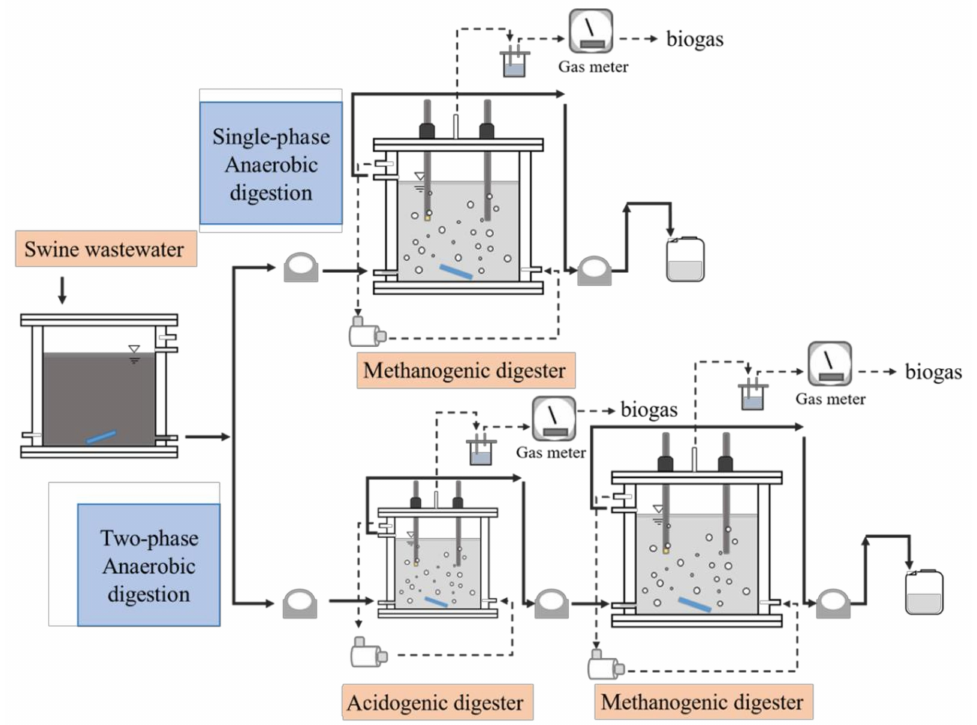
Figure 1. Scheme of single-stage and two-stage